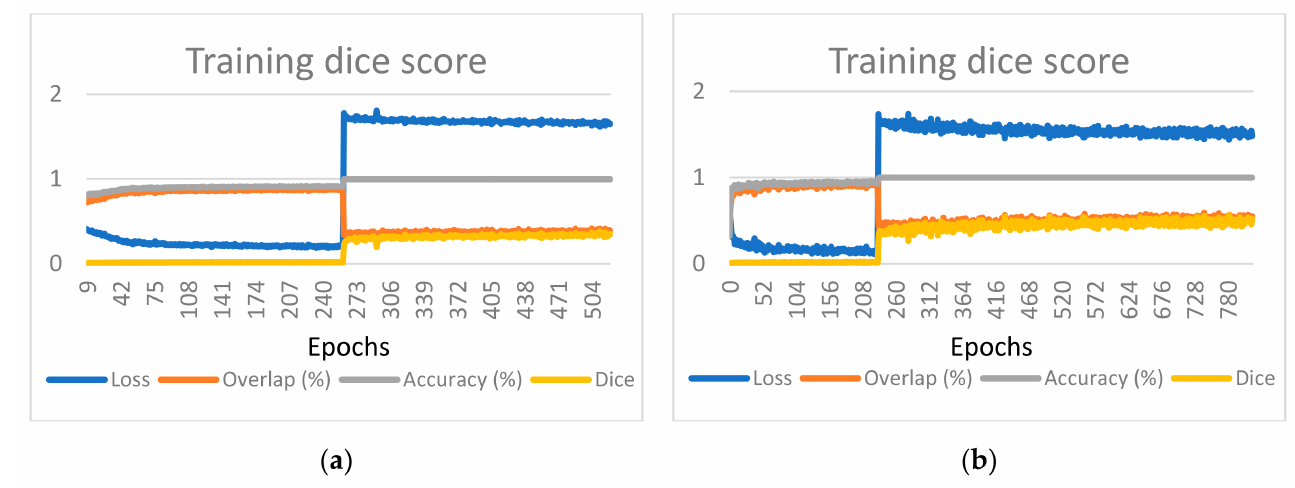
Figure A2. Loss function switch for ( a ) patch size 128 × 128 × 128 and ( b ) Patch size 256 × 256 × 128. Appendix B. Visual Validation for Other Training Configurations